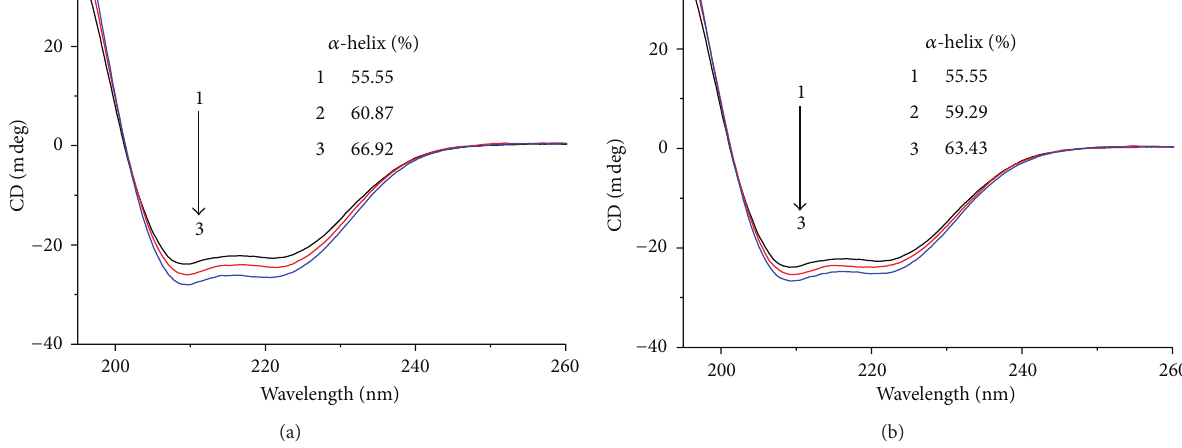
Figure 7: CD spectra of BSA in the presence of CA (a) and LB (b) (𝑇 = 310 K , pH = 7.40) . C(BSA) = 2.0 ×10 −6 mol L −1 ; C(CA or LB)/( 10 −6 mol L −1 ), 1–3: 0, 10,